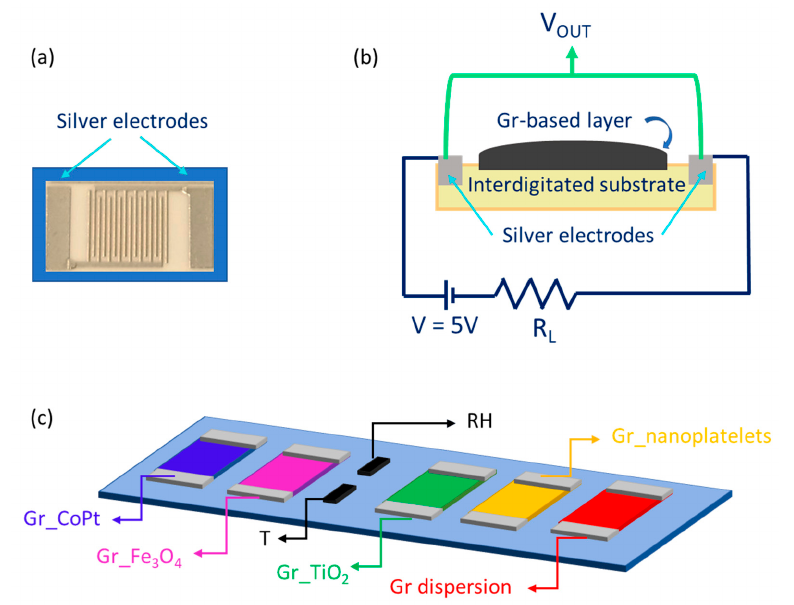
Figure 1. ( a ) A picture of the bare interdigitated alumina substrate with the silver electrodes; ( b ) the readout scheme of each chemiresistor sensor. ( c ) A schematic representation of the sensor array, assembled with the Gr dispersion (red), Gr_nanoplatelets (yellow), Gr_TiO 2 (green), Gr_Fe 3 O 4 (purple), and Gr_CoPt (blue). Relative humidity (RH) and temperature (T) commercial sensors are mounted in the middle of the array.